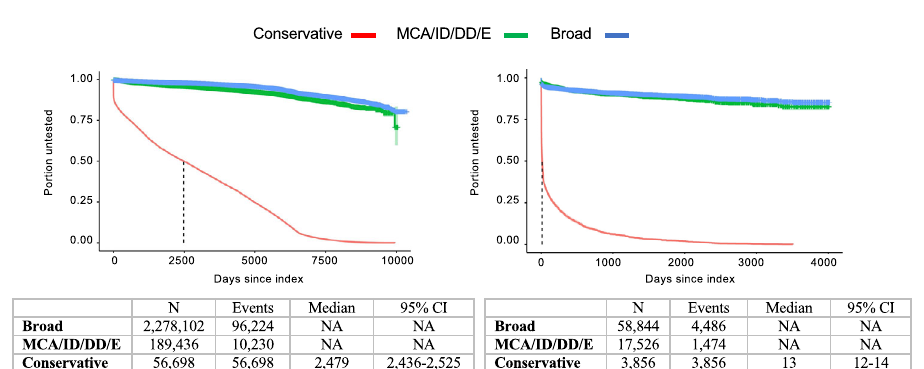
Fig. 1 Time to fi rst genetic test. a Pediatric populations; b critically-ill newborn populations. MCA/ID/DD/E: MCA multiple congenital anomalies, ID intellectual disability, DD developmental delay, E